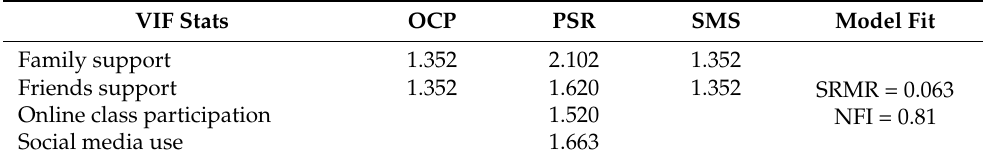
Table 7. VIF stats and model fitness.